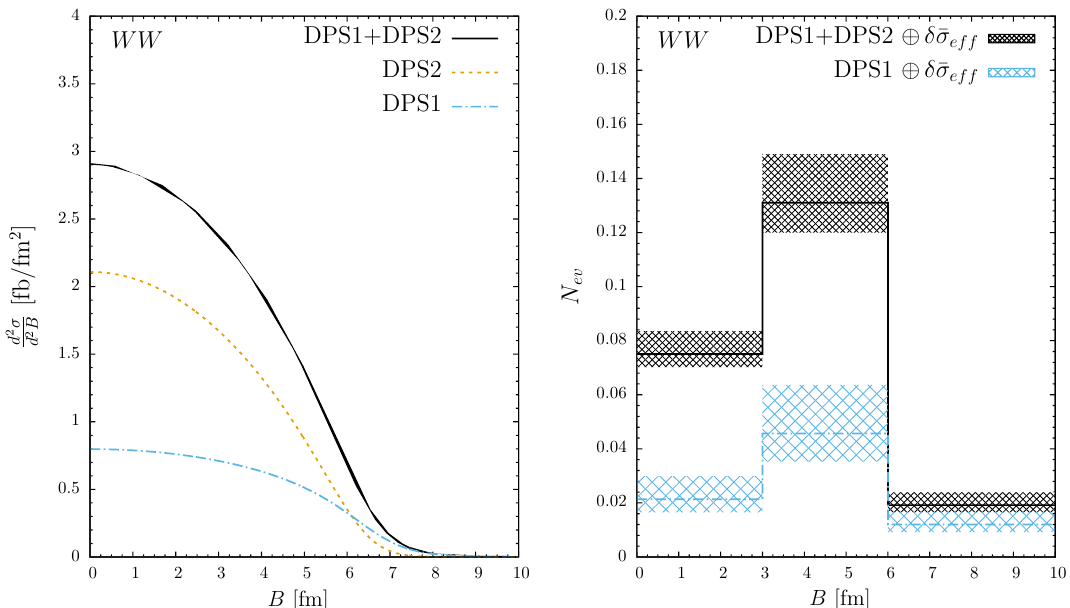
(cid:4) L dt = 1 pb − 1 in the charged summed dimuon channel